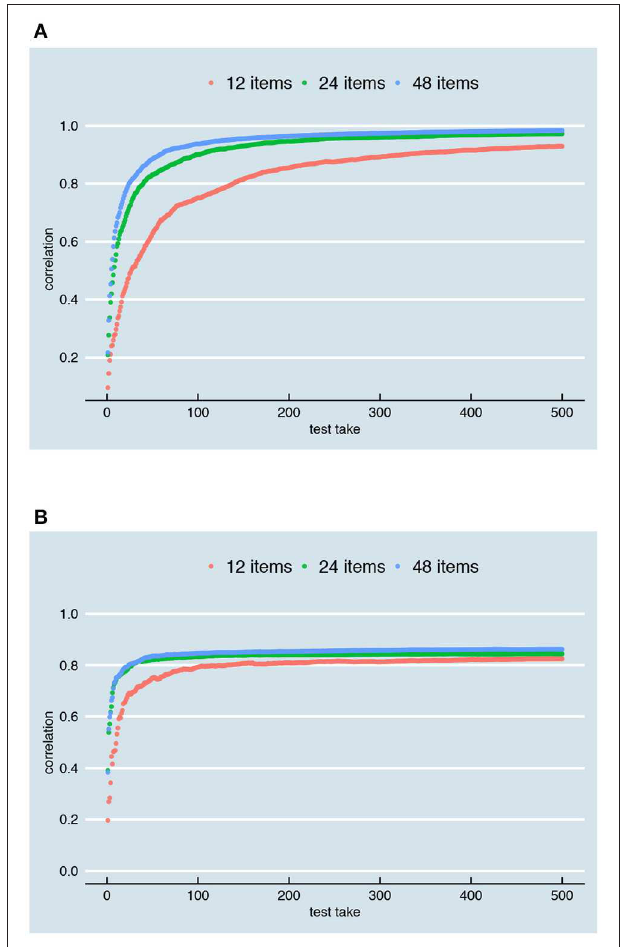
FIGURE 12 | Correlation between the true error variance and the SEm-estimate for different number of test takes (x-axis) and a test with respectively 12, 24, and 48 items. (A) Shows the correlations for the person-specific SEm; (B) A comparable figure for the conditional SEm. Both are based on continuous parallel test scores, an overall reliability of 0.8 and a relationship between “true” score and error variance as depicted in Figure 5A .